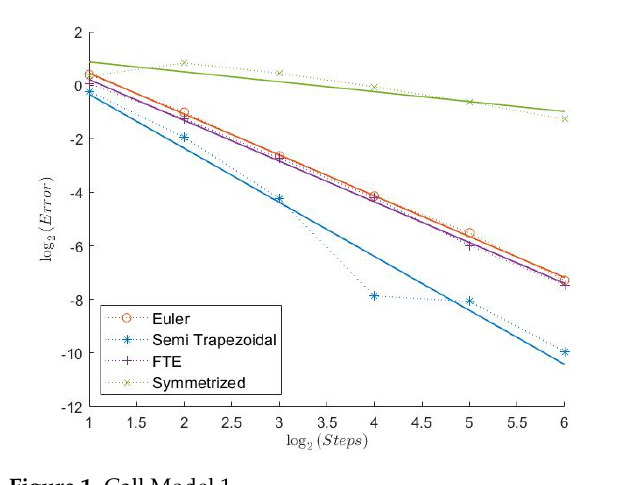
Figure 1. Call Model 1.